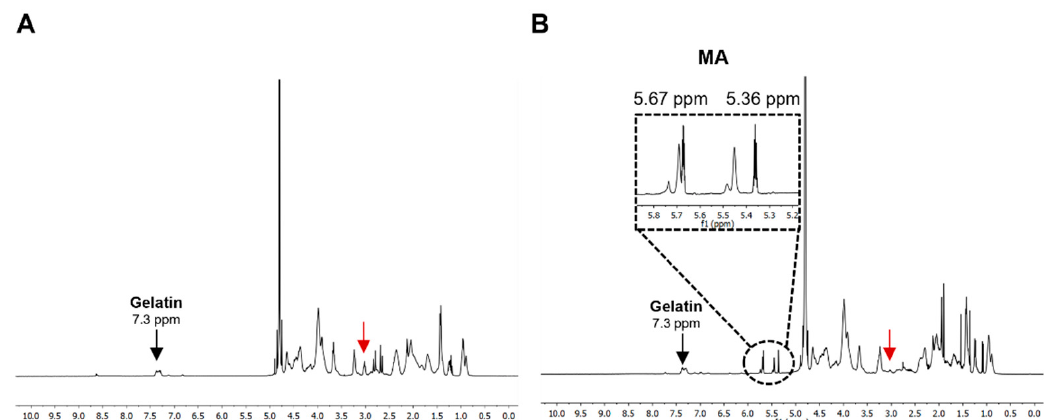
Figure 2. 1 H-NMR spectra of codfish gelatin ( A ) and codfish gelatin methacryloyl ( B ). The red arrow represents the lysine methylene peak.